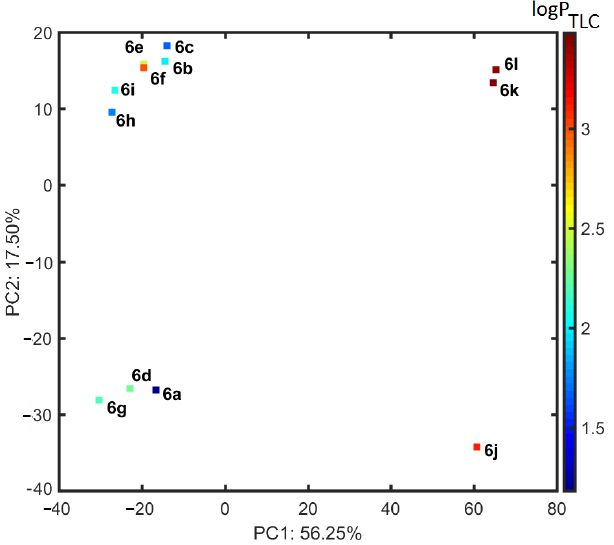
Figure 3. Projection of molecules 6a – l on plane defined by PC1 and PC2 with corresponding experimental lipophilicity in logarithmic scale. Colours code logP TLC values.